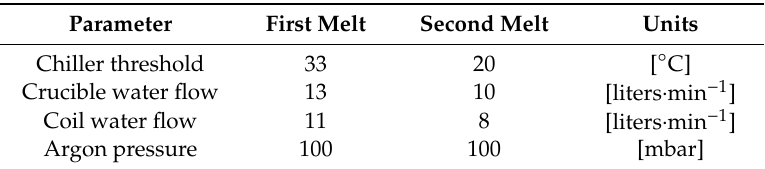
Table 2. Each melting trial process